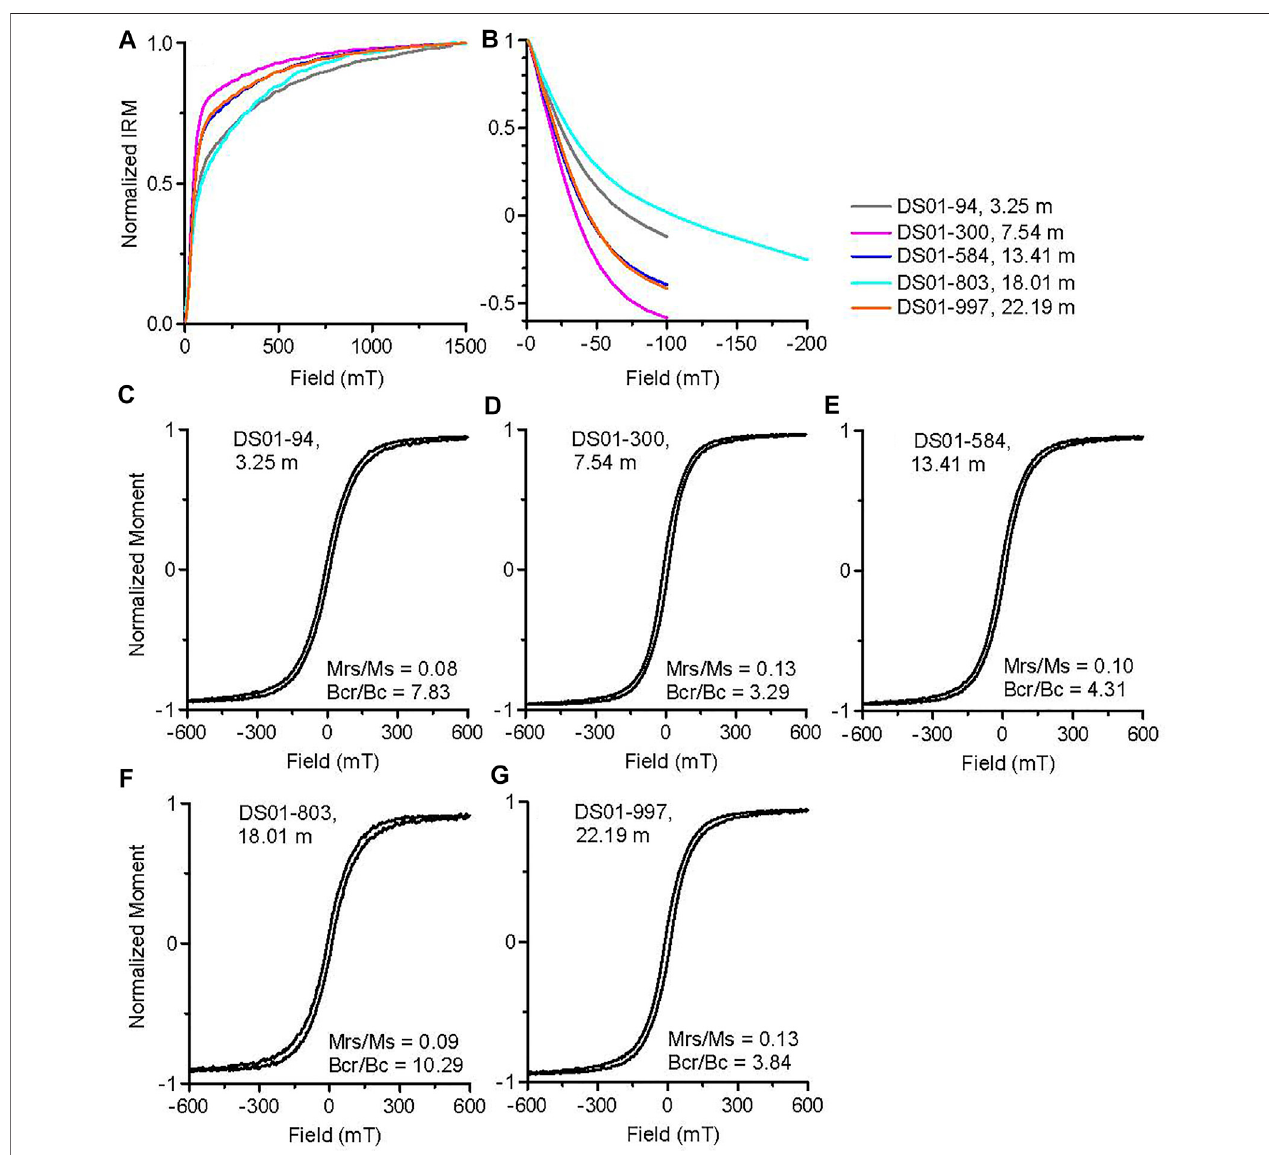
FIGURE 3 | IRM acquisition curves and back fi eld IRM curves (A , B) and hysteresis loops (C – G) for representative samples from core DS01. Ms, saturation magnetization; Mrs, saturation remanence; Bc, coercivity; Bcr, coercivity of remanence. Hysteresis loop data of the samples shown in (C – F) were processed using the HystLab program (Paterson et al.,